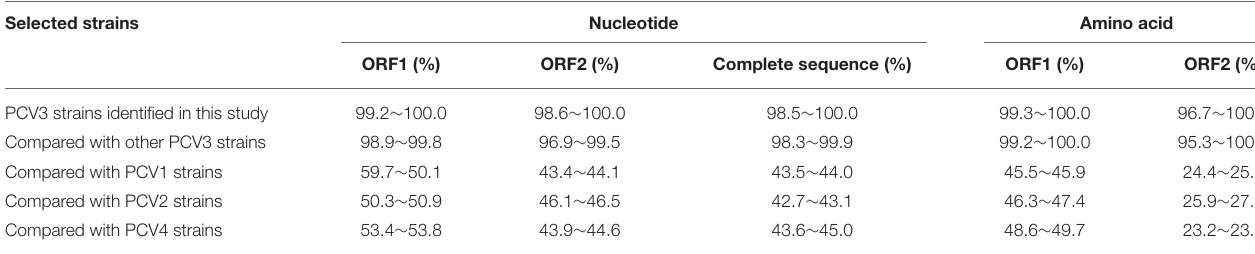
TABLE 6 | Sequence homology analysis of the PCV3 strains identified in the present study. Selected strains